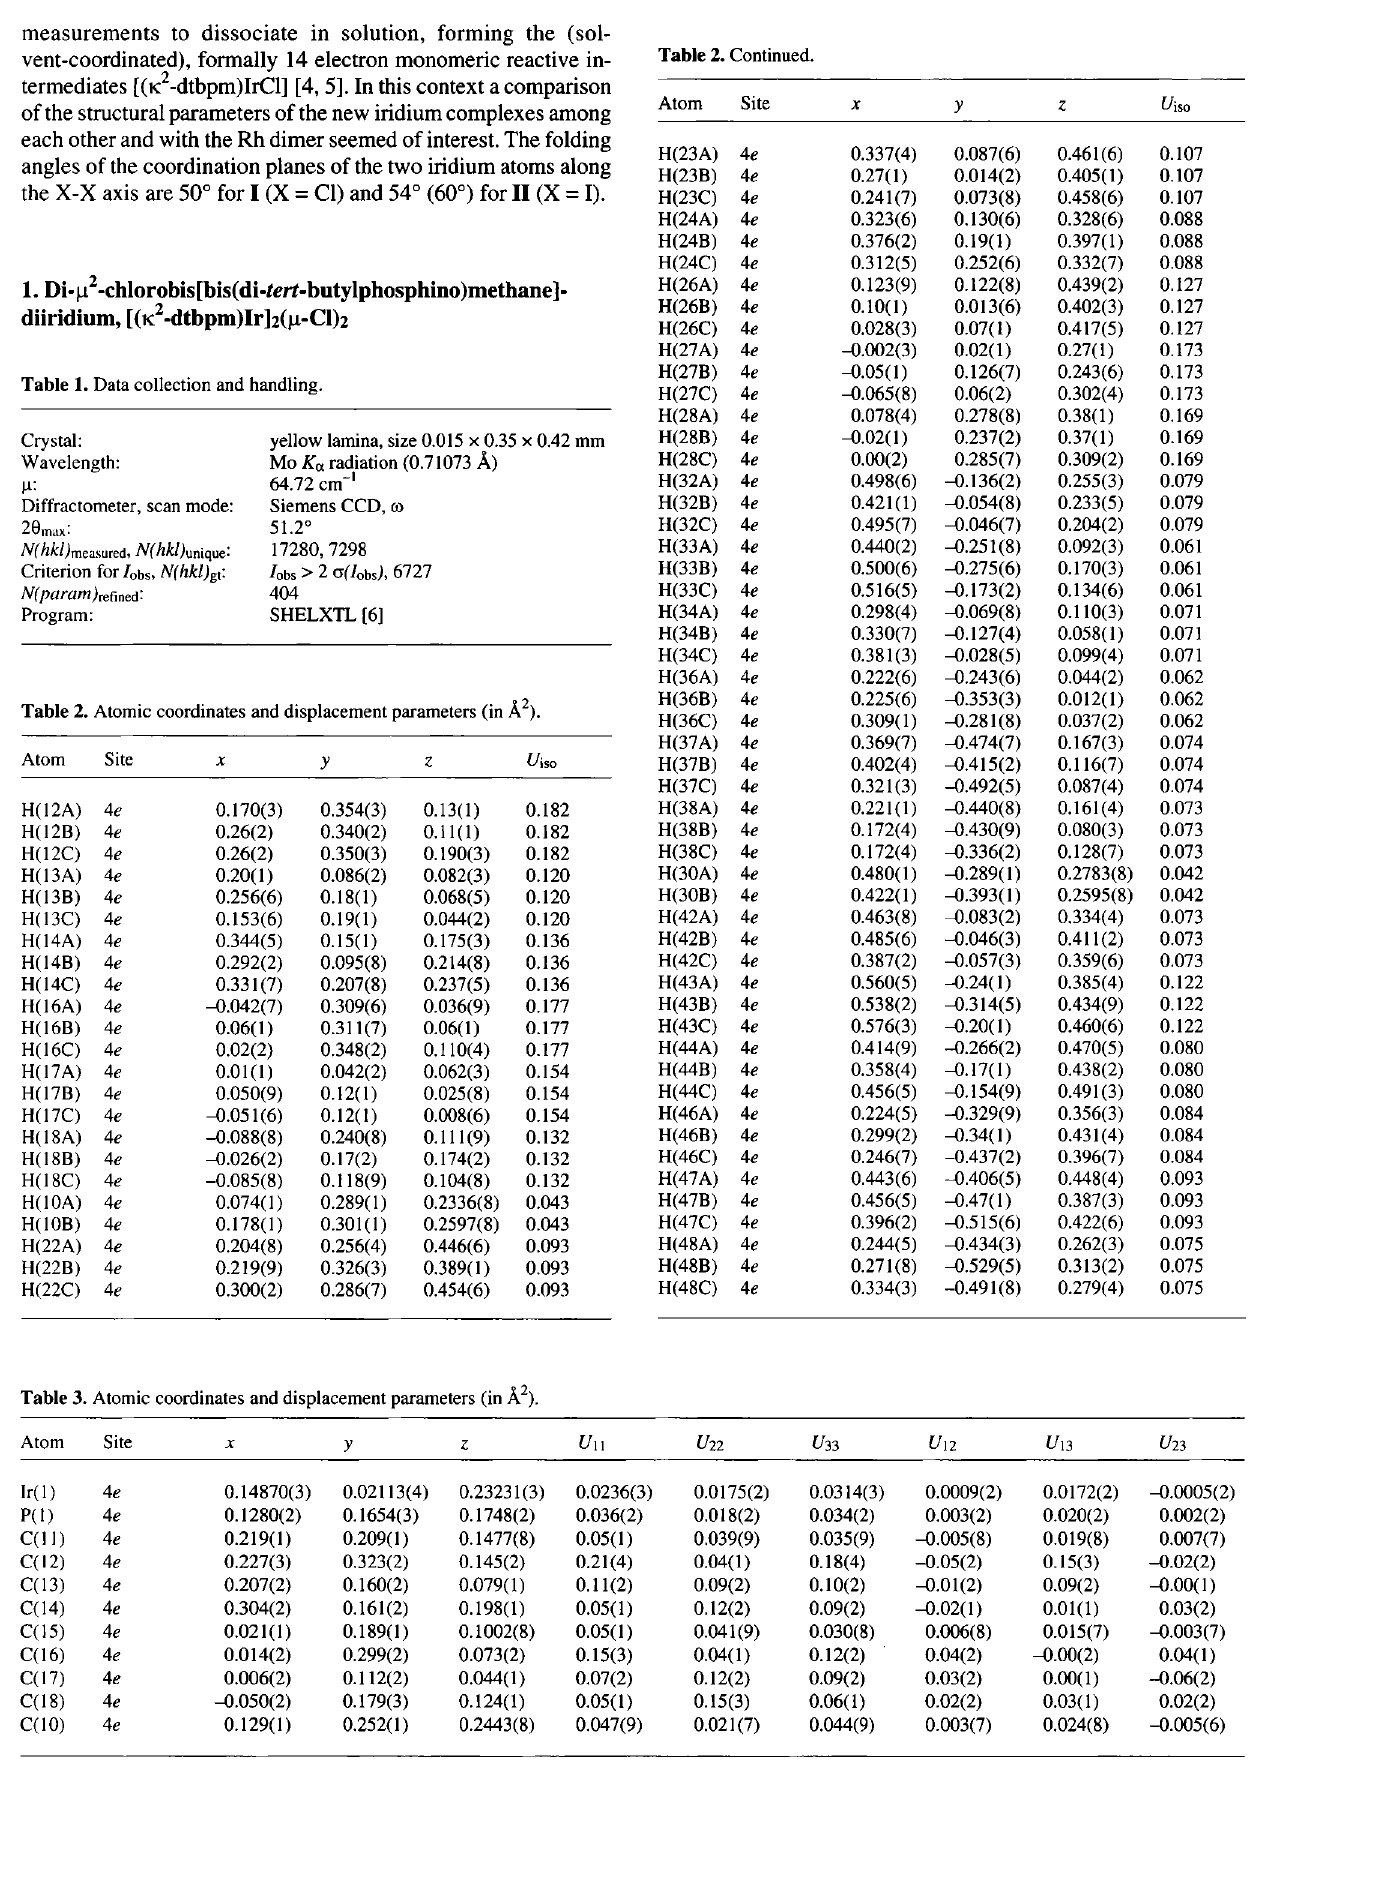
Table 1. Data collection and handling.